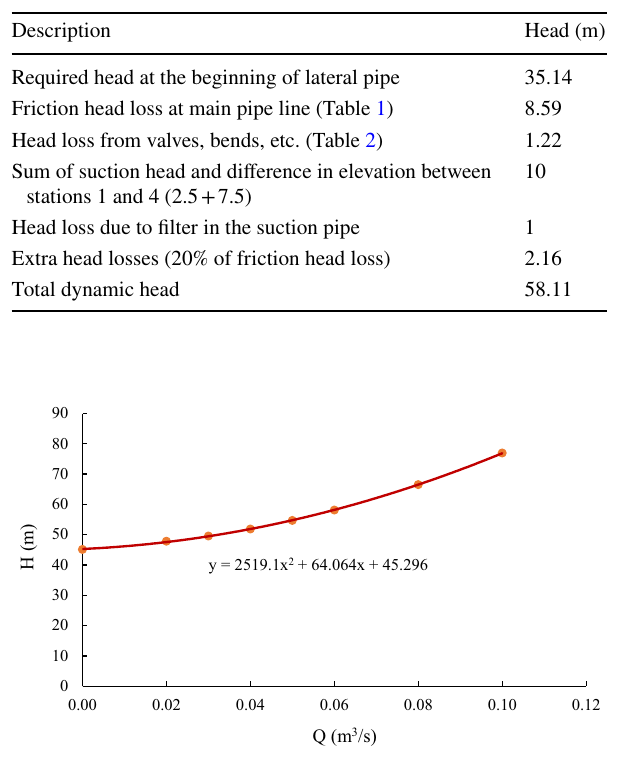
Table 3 Total dynamic head required by the sprinkler irrigation sys-